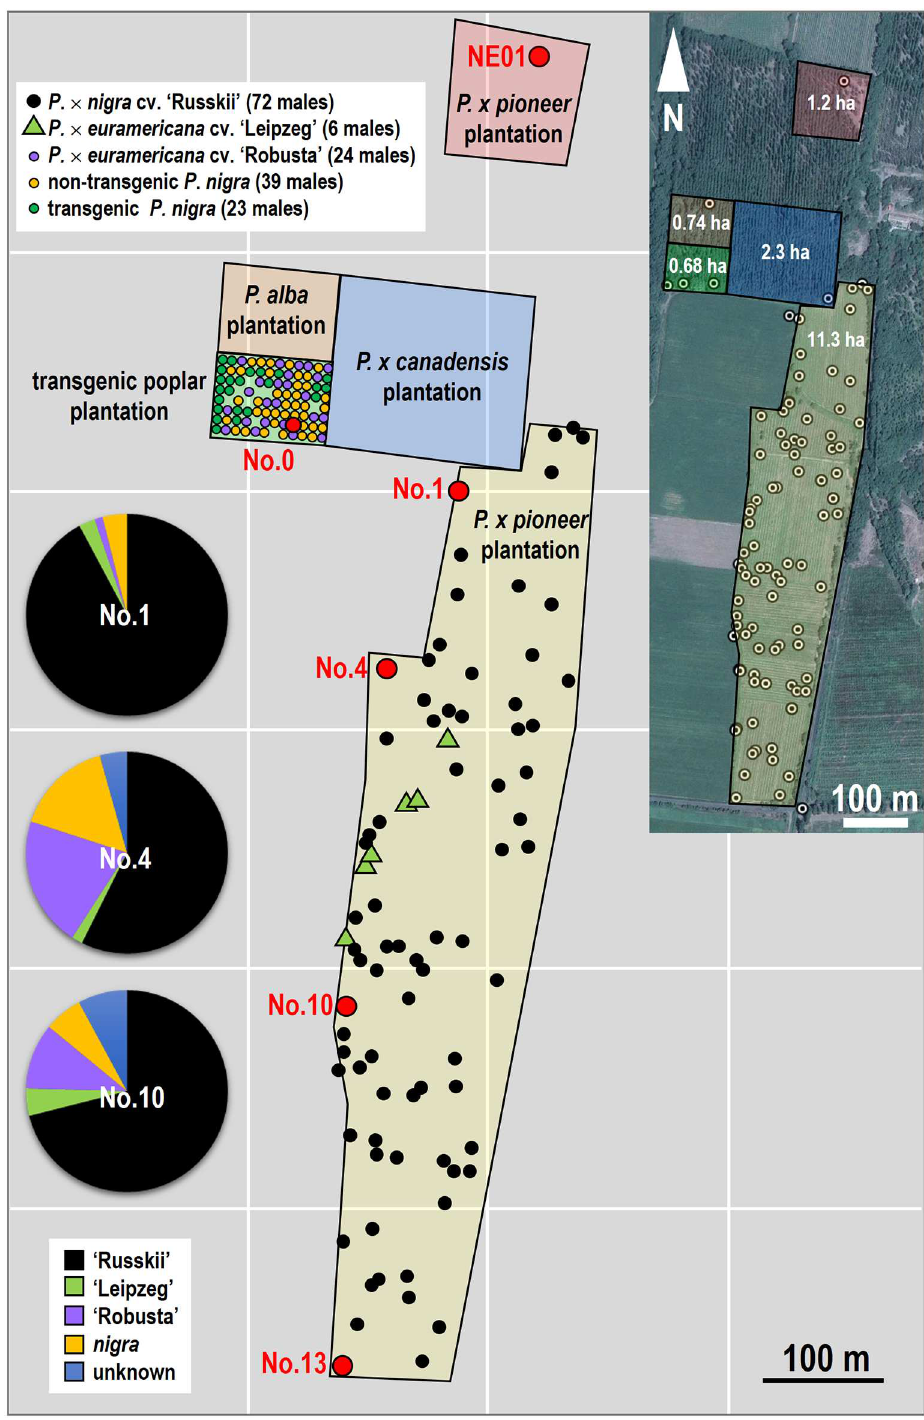
Fig 1. Sketched map of the sites of the transgenic poplar plantation (TPP) and the surrounding non- transgenic plantations. There were 23 Bt floweringtransgenic male poplartrees and 63 non-transgenic male trees (39 non-transgenic P . nigra clonal trees and 24 P . × euramericana cv. ‘Robusta’clonal trees) in the TPP, whilethere were 72 P . nigra cv. ‘Russkii’( P . nigra cv. ‘Italica’ × P . nigra )clonal trees and six P . × euramericana cv. ‘Leipzeg’clonal trees distributedin the southeast ‘Pioneer’plantation. The trees in the ‘Pioneer’plantationthat were sampledfor seed collectionwere located in both the southeast (No. 0, No.